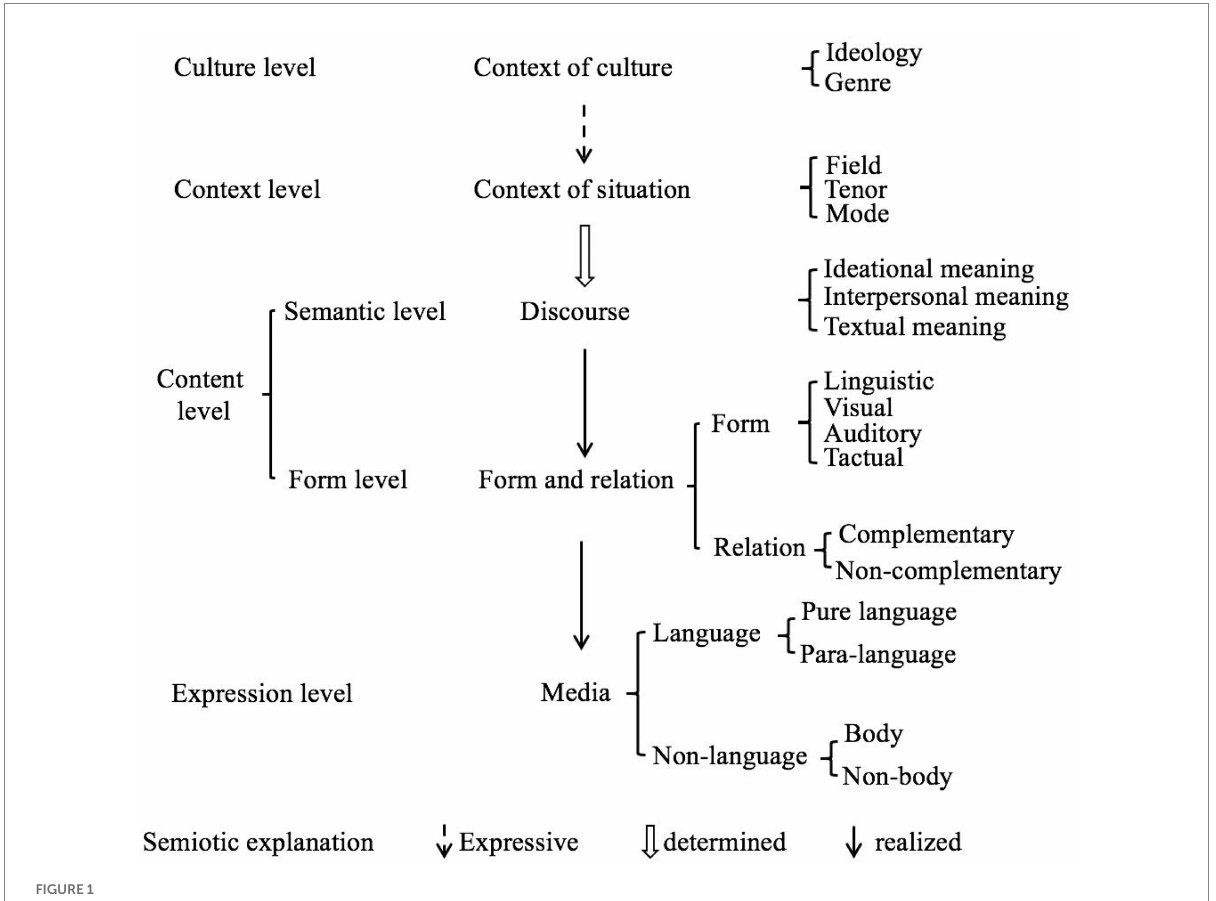
FIGURE 1 Framework of MDA (Zhang,